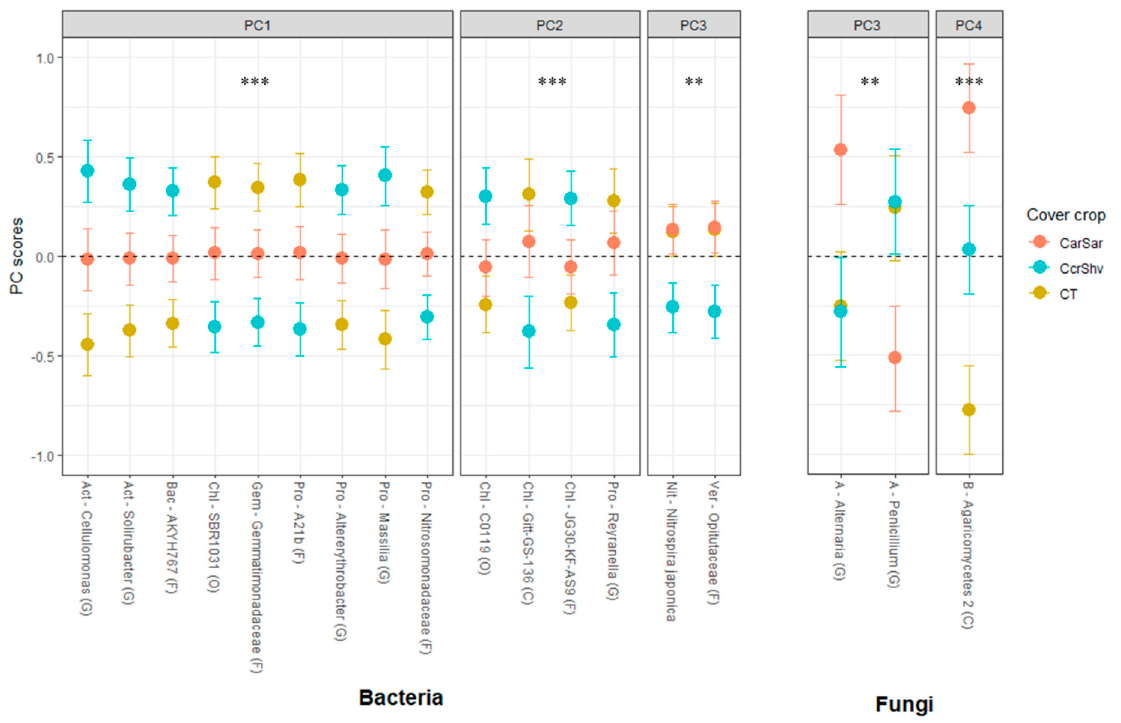
Figure 2. Response pattern of the bacterial and fungal indicator OTUs to cover cropping. Visual representation of the combined results of the principal component analyses (PCAs) and their mean separation procedures showing the most responsive bacterial and fungal indicator OTUs based on Table 4. for PC5 (Figure 3) and PC6. The mean separation procedures showed that the mean PC scores were greater with chisel tillage for PC1, PC2, and PC3. The mean PC score was statistically smaller with CT than CarSar and CcrShv for PC1, but that of CcrShv was smaller than CT and CarSar for PC2 and PC3. For PC5, the mean PC score of NT × CcrShv was statistically greater than T × CcrShv, with all other CC and tillage interactions being intermediate between the two. For PC6, the mean PC scores of T × CT and NT × CarSar were statistically greater than those of NT × CcrShv and T × CarSat, while NT × CT and T × CcrShv took intermediate values. **, ***, significant at the 0.05 and 0.01 probability levels, respectively.